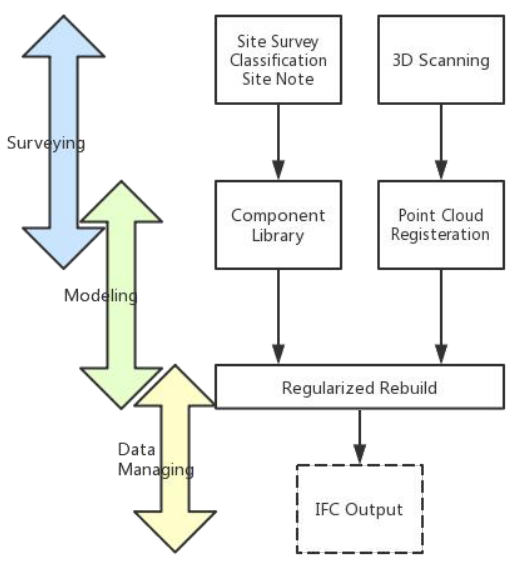
Figure 25. Workflow of Regularized